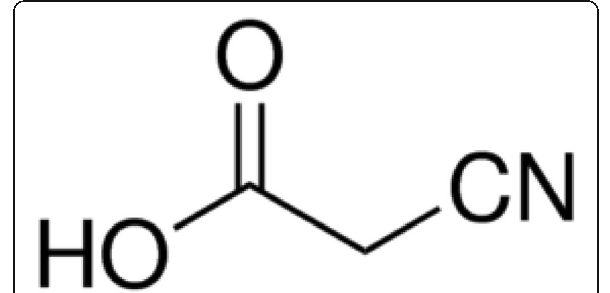
Fig. 2 Chemical structure of cyanoacetic